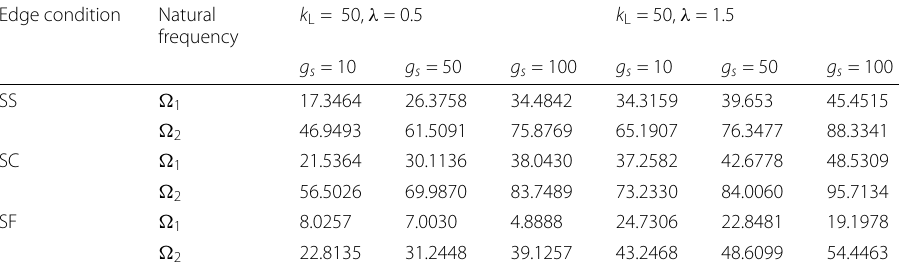
Table 2 Two-parameter foundation effect on first two natural frequencies of vibrating rectangular plate Edge condition Natural frequency